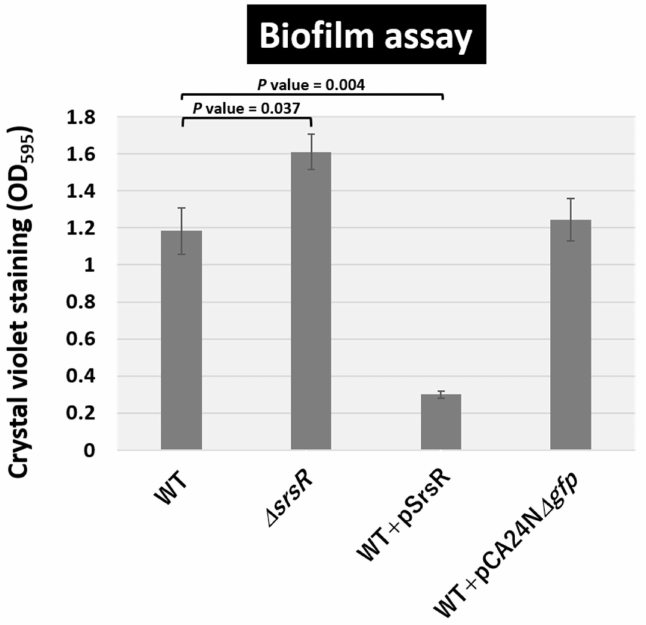
Figure 6. Level of biofilm formation. E. coli K-12 wild-type, the isogenic srsR mutant JW5476, the wild- type strain harboring SrsR overexpression vector, and its empty vector were grown in LB medium at 37 ◦ C for 24 h in a plastic tube. The level of biofilm formation was measured by crystal violet staining. The relative level of biofilm represents the mean ± SD of three experiments. Statistically significant differences were obtained using the Student’s t-test with multiple comparisons’ correction and are represented by line over bars with associated p